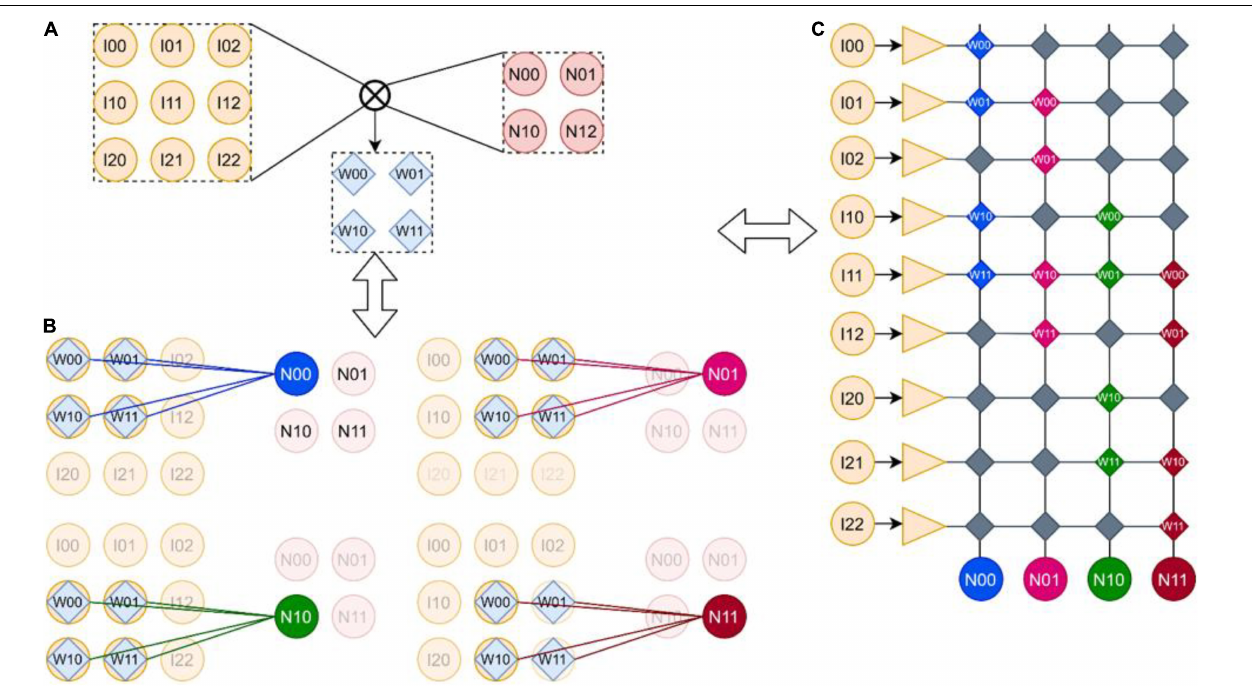
FIGURE 4 | (A) Convolution kernels. (B) Convolution process. (C) The mapping of convolution in memristor array. One 2 × 2 convolution kernel strides successively on the 3 × 3 input feature image, and outputs a 2 × 2 feature image; the convolution layer can be mapped to RRAM but wastes a lot of area.